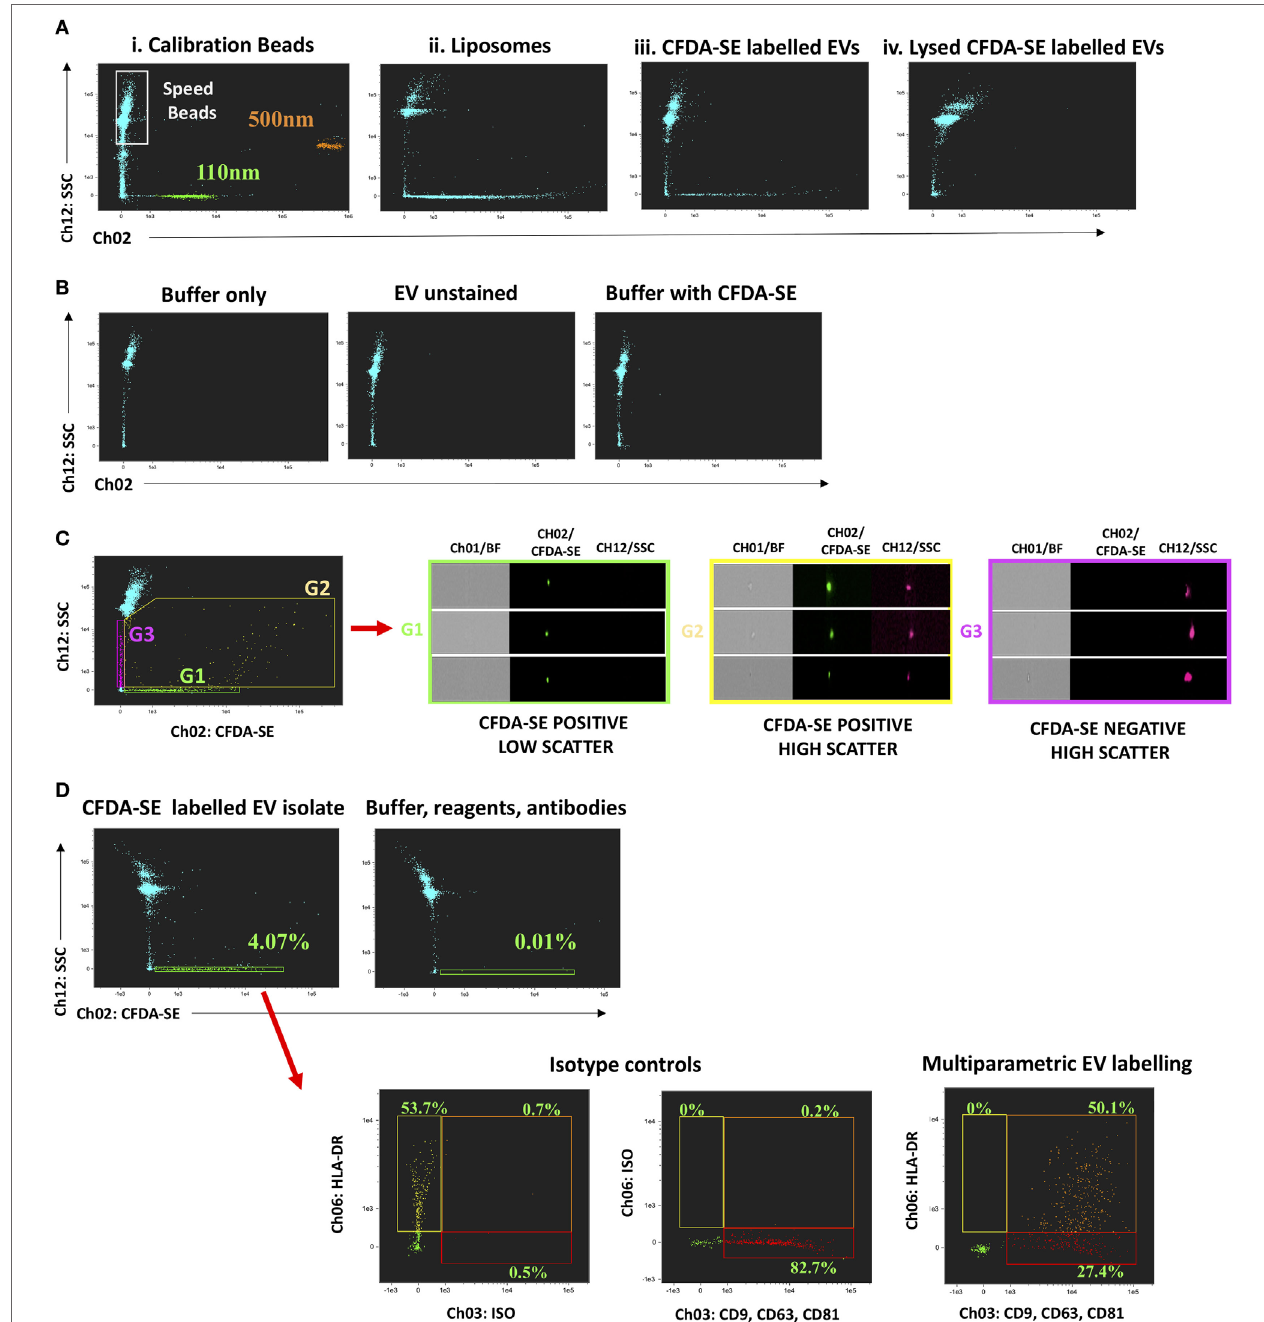
FIgURe 1 | Submicron particle detection and multiparametric characterization of circulating “small EV” (sEV) by ImageStream x (ISx). Gating sEV populations is achieved by assessment of the Scatter intensity of particles of known size, and through confirmation by single-event visual interrogation. (A) Fluorescently labeled polystyrene beads and liposomes which have a refractive index closer to that of EV are used and contrasted to CFDA-SE labeled circulating human extracellular vesicles (EVs) derived by ultracentrifugation. CFDA-SE-mediated labeling of intact vesicles is demonstrated by detergent lysis (0.1% Triton ™ X-100) of UC-derived EVs prior to labeling. (B) The acquisition of appropriate control samples is an important step prior to running experimental samples if the common pitfalls of flow-cytometric profiling of EVs are to be avoided. Representative ISx dot-plots of buffer alone (filtered phosphate-buffered saline), unstained EVs, and buffer plus reagents without EVs are shown. (C) Representative dot-plot of CFDA-SE Vs. Scatter intensity to demonstrate the heterogeneity of acquired events and the principle of visual interrogation in gate-setting. The difference in properties of the two CFDA-SE-positive populations (G1 and G2) is clear by visual interrogation, showing G2 to be predominantly composed of cellular debris or particle aggregates as opposed to the uniform particles in G1—the sEV gate. (d) Multiparametric phenotyping of these gated sEV (G1) is demonstrated by fluorescent labeling with EV markers, the tetraspanins CD9, CD63, and CD81 combined (PE, Ch03) and HLA-DR (PECy7, Ch06). Fluorescence minus one and isotype controls are used to set gating. A buffer + reagent + antibody control should be performed and is demonstrated